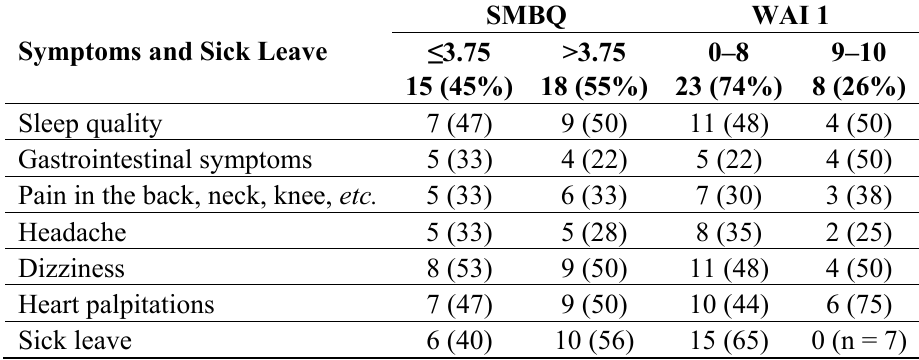
Table 2. Distribution at baseline for reporting absence of symptoms and more than 14 days of sick leave for participants scoring ≤ 3.75 and ˃ 3.75 on SMBQ and 0–8 and 9–10 on WAI 1. Symptoms and Sick Leave